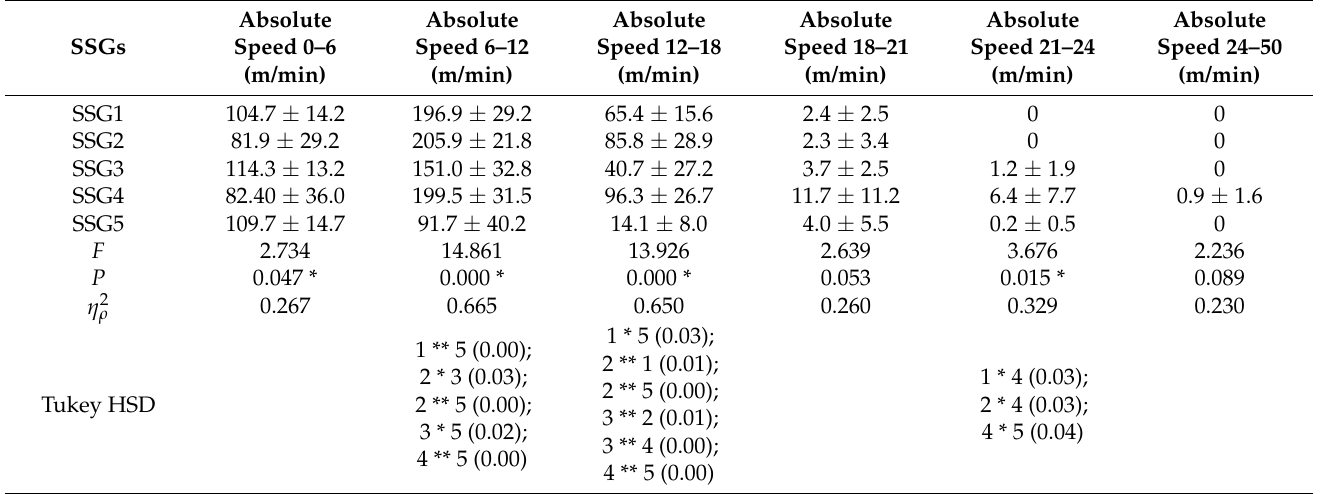
Table 4. Soccer players distance covered at different interval speeds in all the performed small-sided